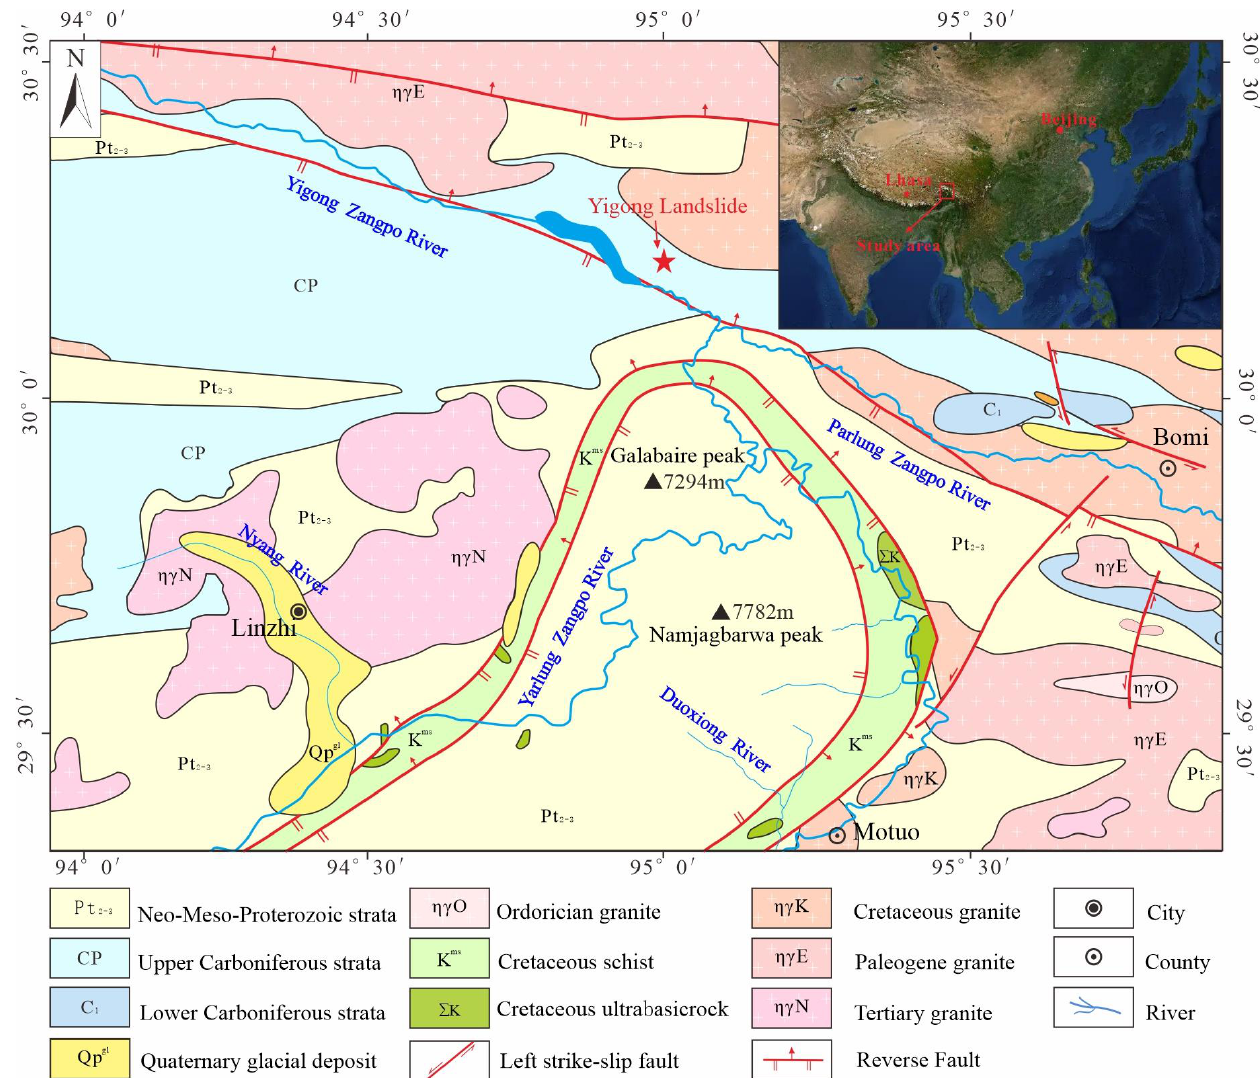
Figure 1. Geological map of the study area. (Geological map data from China Geological Survey; The upper right corner remote sensing map is from Google Earth in 2022).